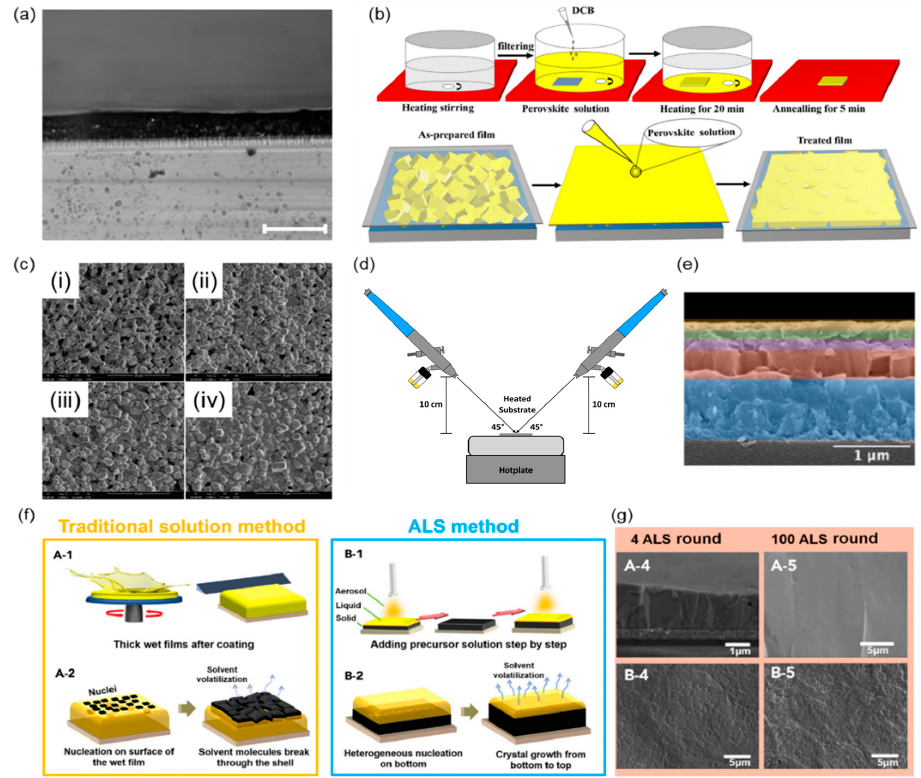
Figure 2. Spin-coating, dissolution and recrystallization, spray deposition, and aerosol–liquid–solid methods. ( a ) The cross-sectional optical microscopy of perovskite films and the scale bar is 100 μ m. Reprinted with permission from Ref. [27]. 2015, Springer Nature. ( b ) CsPbBr 3 thick film preparation and repair process diagram. Reprinted with permission from Ref. [26]. 2019, Wiley. ( c ) SEM images of (i) the original CsPbBr 3 thick film, and the treated thick films with (ii) 5, (iii) 10, and (iv) 20 times dissolution and recrystallization. Reprinted with permission from Ref. [26]. 2019, Wiley. ( d ) Spraying device for depositing double-layer perovskite film. Reprinted with permission from Ref. [28]. 2020, Optica. ( e ) SEM cross-sections of different layers of perovskite solar cells. Reprinted with permission from Ref. [28]. 2020, Optica. ( f ) Comparison of traditional solution-based approach to film production ( left ) and the aerosol–liquid–solid method ( right ). This highlights the latter’s unique ability to manufacture high-quality thick perovskite films. Reprinted with permission from Ref. [29]. 2021, Cell Press. ( g ) Cross-section ( upper ) and top-view SEM images ( lower ) of perovskite films fabricated by the aerosol–liquid–solid method after 4 ( left ) and 100 growth cycles ( right ). Reprinted with permission from Ref. [29]. 2021, Cell